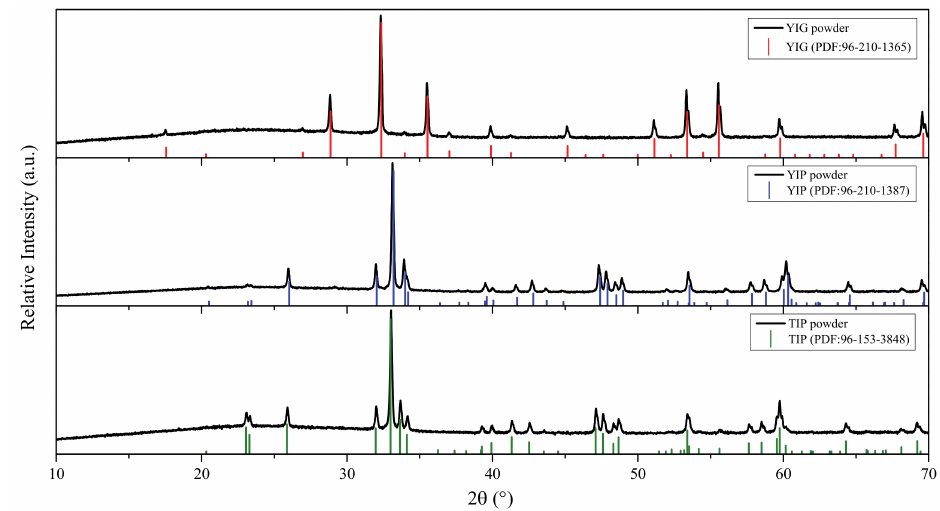
Figure 2. XRD patterns of yttrium iron garnet (YIG), yttrium iron perovskite (YIP), and terbium iron perovskite (TIP) powders obtained by the aqueous sol-gel